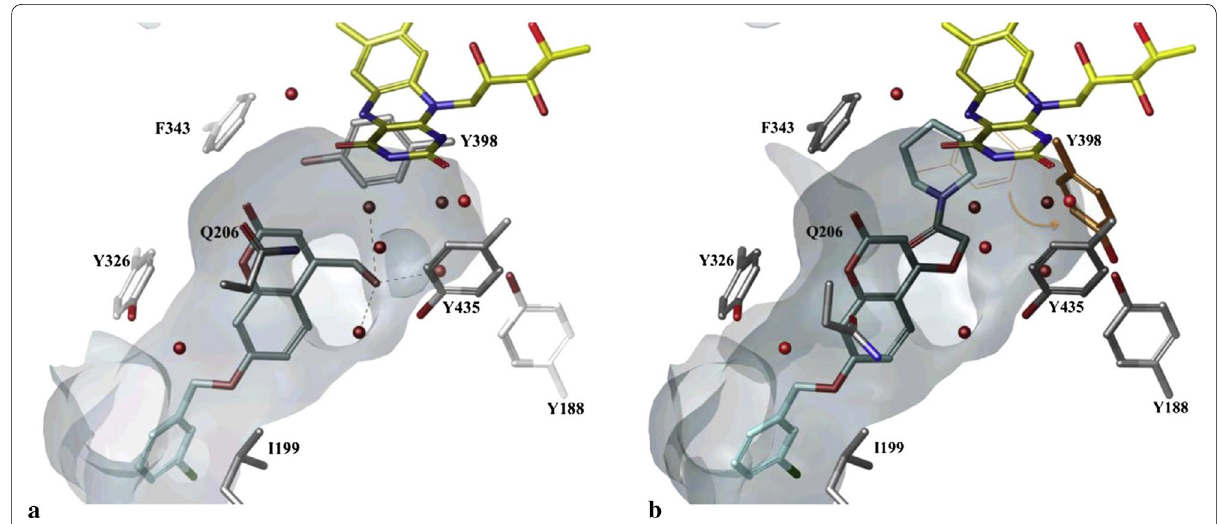
Fig. 72 Top-ranked docking pose of compounds C86 20 ( a ) and C86 66 ( b )